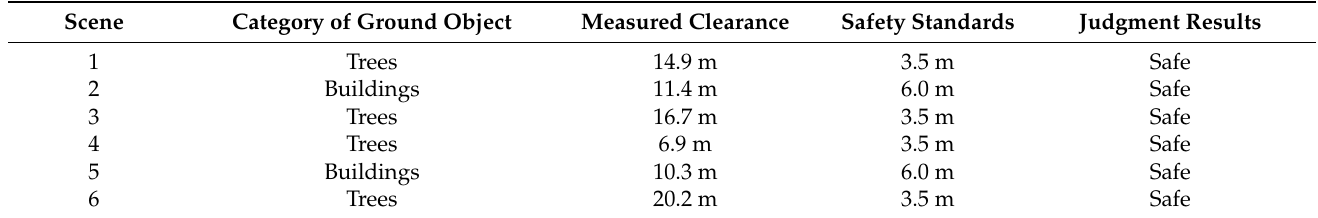
Table 8. Results of ground clearance detection in the tested 220-kV transmission line corridor.